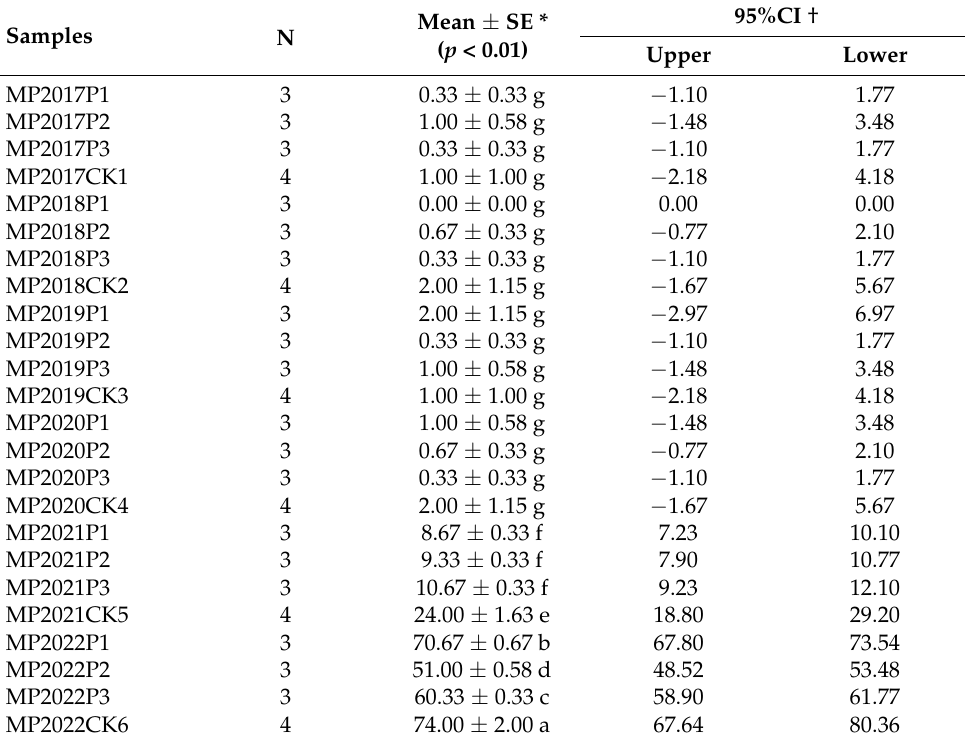
Table 2. Seed germination triggered by osmoregulation treatments with different concentrations of PEG-6000.